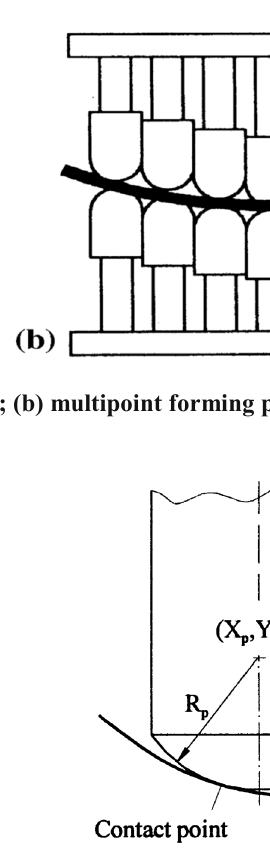
Fig. 2. Determination of element position.